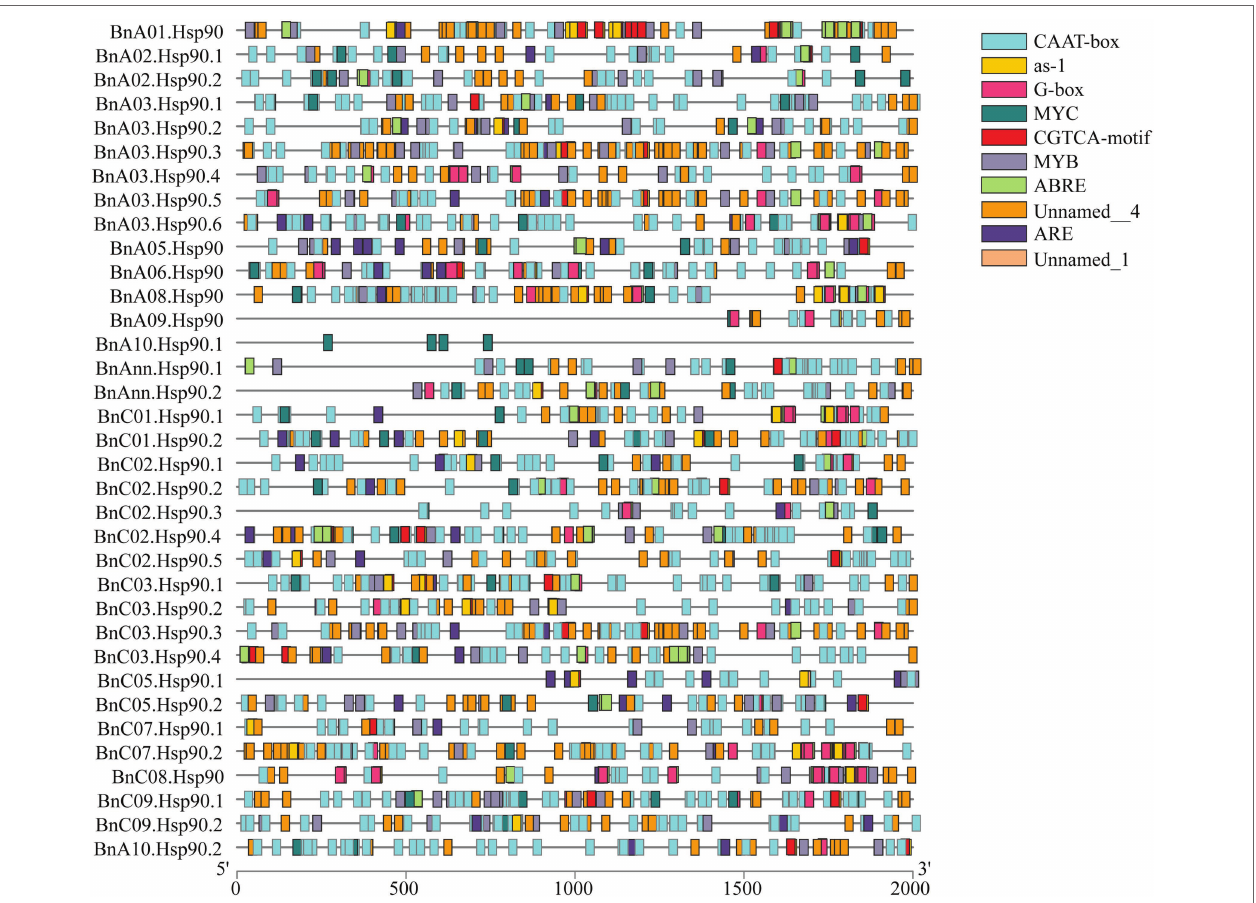
FIGURE 4 | Predicted stress-related cis-elements in BnHsp90 promoters. Promoter sequences (2,000 bp upstream region) of 35 BnHsp90 genes were analyzed online at PlantCARE web server. Different colors were used for indicating different cis-elements, as shown on the right